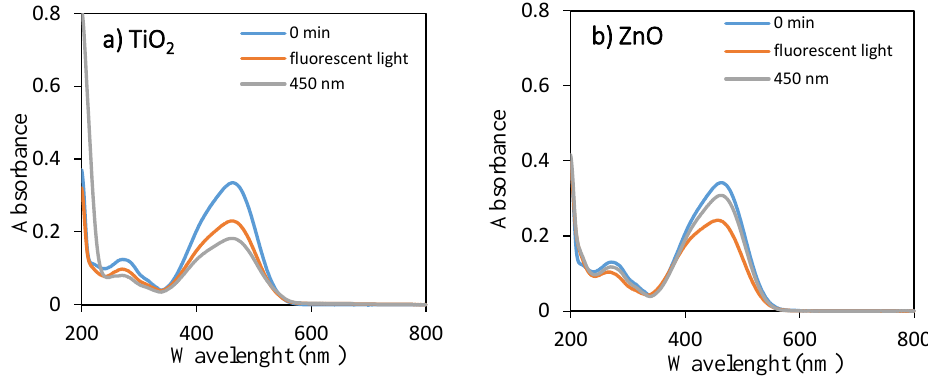
Figure 1. UV – visible spectra of aqueous solutions of OII for 0 min and 360 min using ( a ) TiO 2 and ( b ) ZnO under fluorescent and 450 nm LED lights.